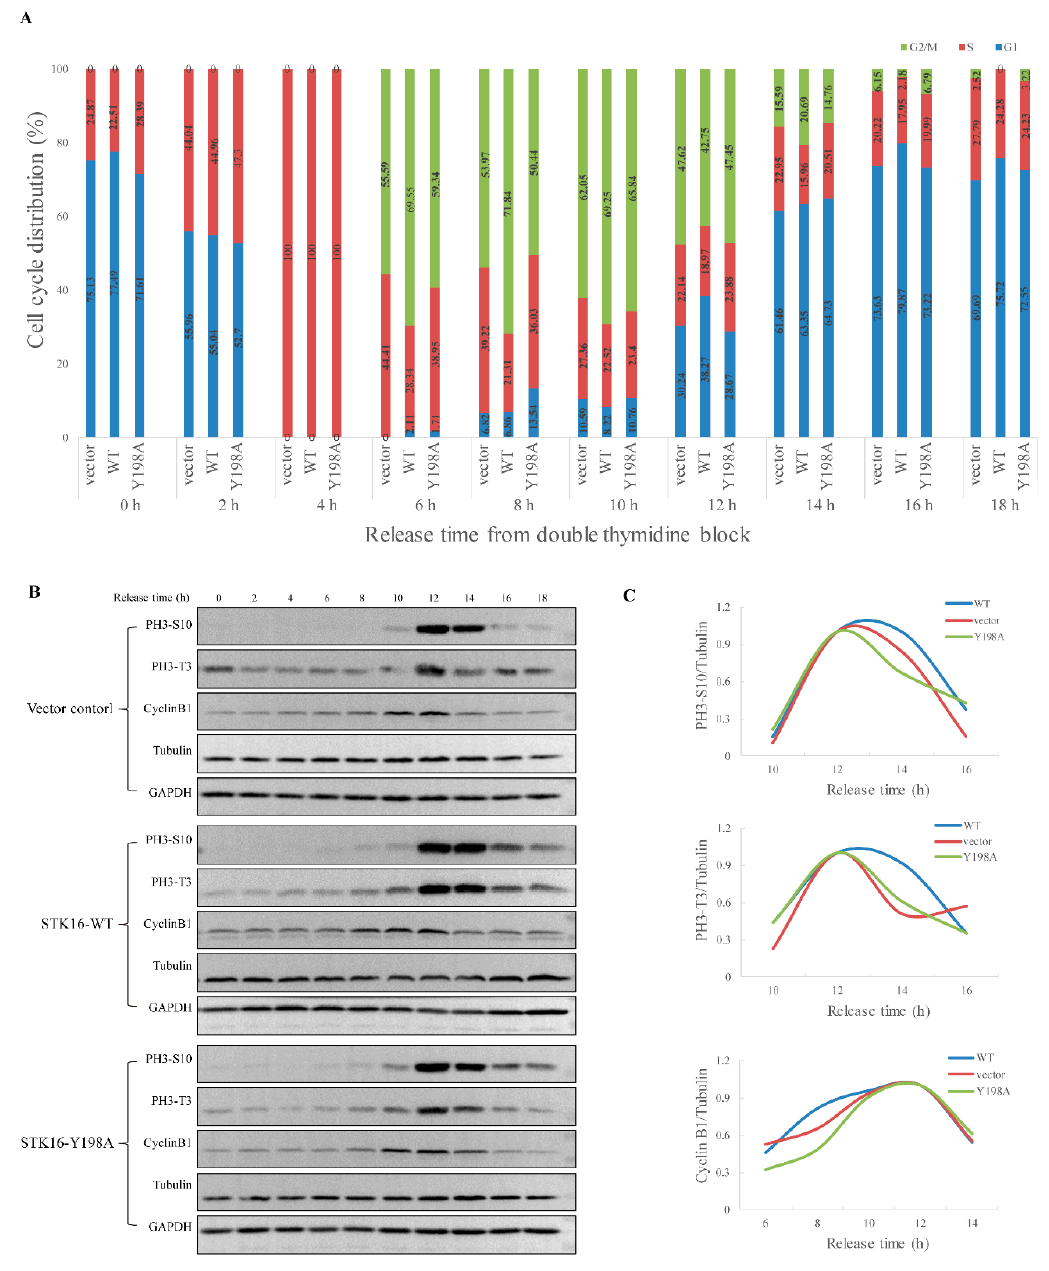
Figure 6. Tyr198 is critical for STK16 to regulate cell cycle. HeLa-GFP-FLAG (vector control), HeLa-STK16 WT-GFP-FLAG, and HeLa-STK16 Y198A-GFP-FLAG cell lines were synchronized by double thymidine release, and the cell cycle was detected by fluorescence-activated cell sorting (FACS) ( A ) and Western blot ( B ) at the times indicated. ( C ) Phospho-Histone H3 (Thr3), phospho-Histone H3 (Ser10), and cyclin B1 were normalized to tubulin. Phospho-Histone H3 (Thr3) and phospho-Histone H3 (Ser10) were used as the mitotic and G2/M makers in Western blots.